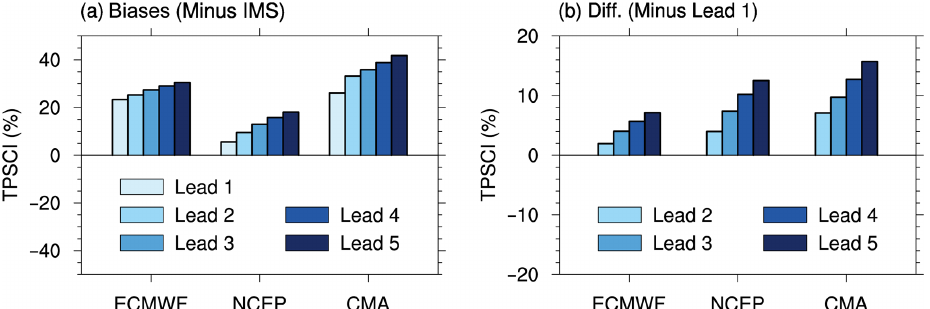
Figure 3. (a) The multiyear wintertime mean biases of the Tibetan Plateau snow cover (TPSC) index (unit: %) in forecasts against those in the Interactive Multisensor Snow and Ice Mapping System (IMS) snow cover analysis. (b) Differences in the multiyear wintertime mean TPSC index between forecasts with a lead of 2–5 weeks and forecasts with a lead of 1 week in each model. Table 1. The proportion of increasing (decreasing) weeks in the observations and forecast models with different lead times (in weeks). Observation/lead =